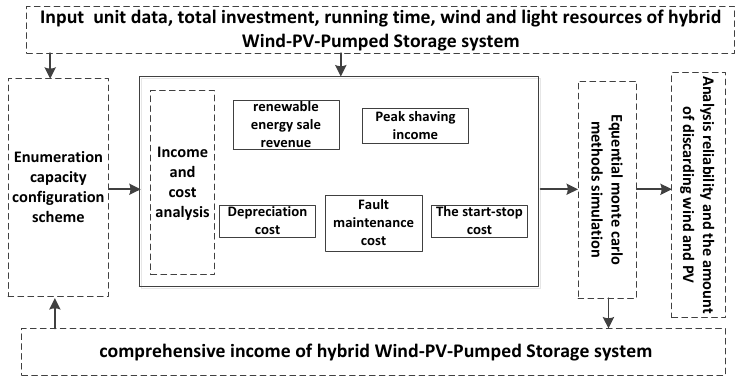
Figure 2. The hybrid renewable energy system capacity configuration method.